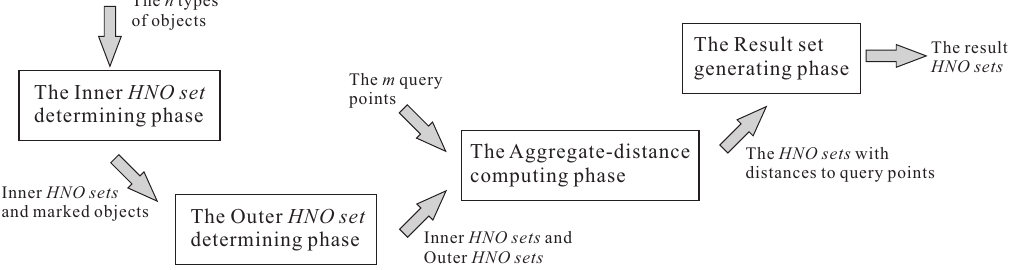
Figure 3. Flowchart of the MRAggQ